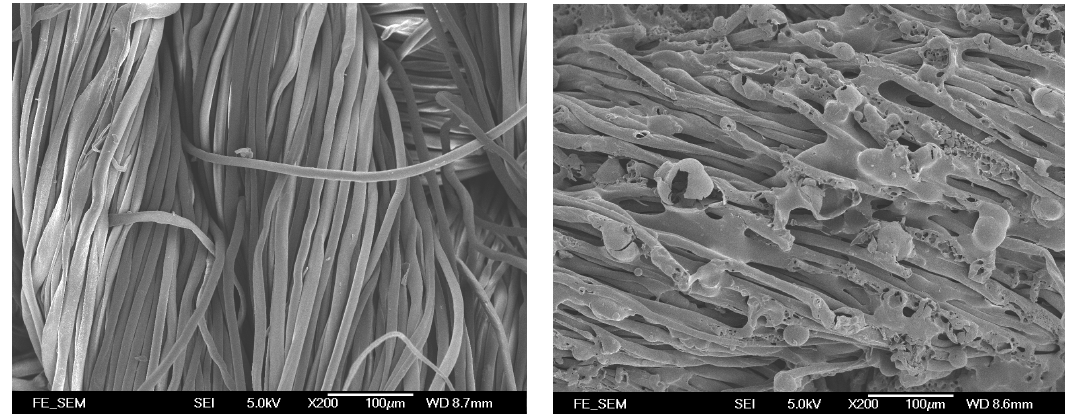
Figure 8. Morphological feature (200×) of control cotton/polyester blended fabric ( left ) and laser-treated cotton polyester blended fabric with variables of 52 dpi/120 µs ( right ). Table 2. Percentage of polyester melted in the fabric.